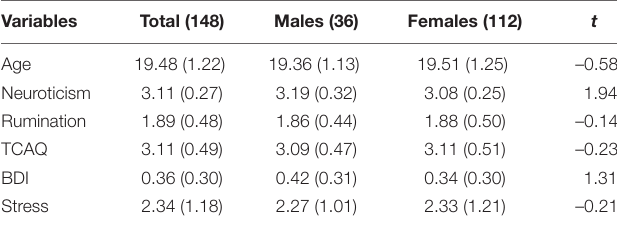
TABLE 3 | Descriptive statistics in Study 2 ( M, SD ).